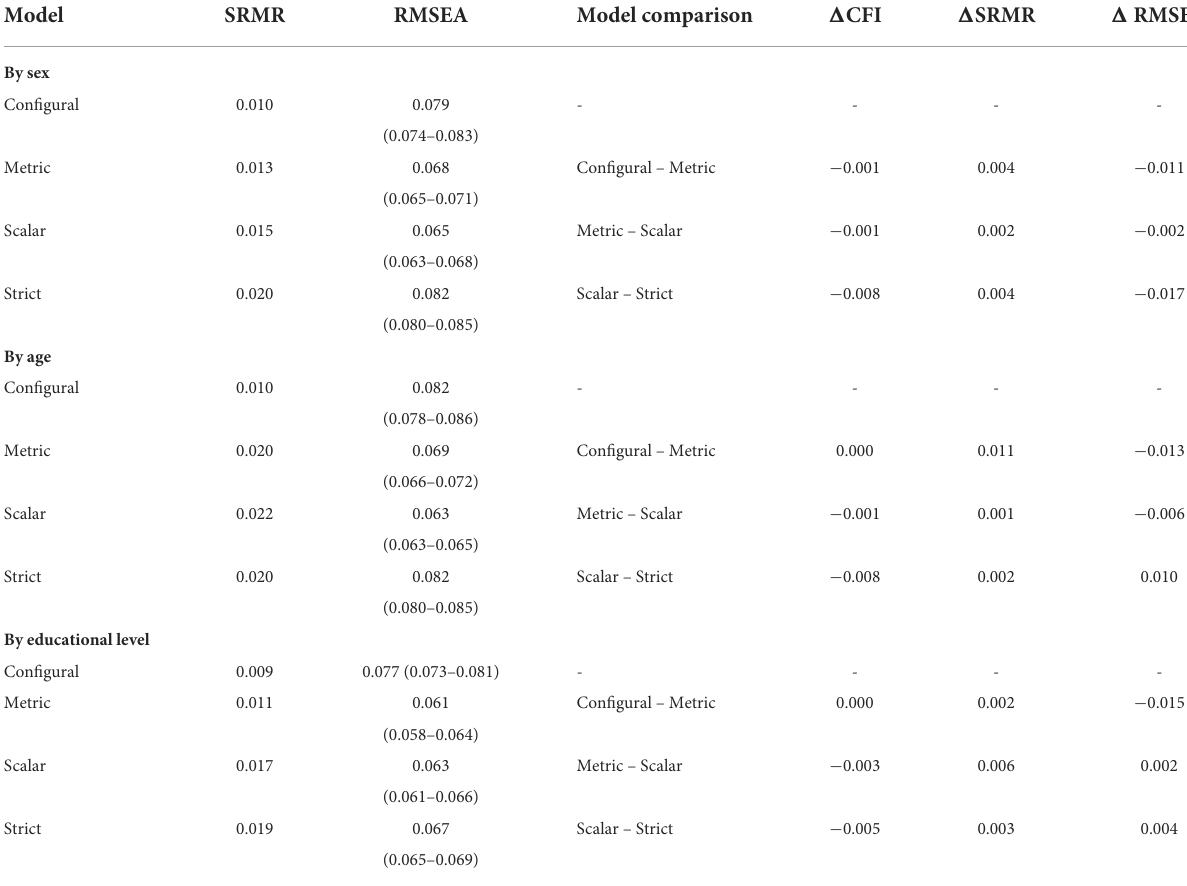
TABLE 4 Alternative fit indices to evaluate measurement invariance by sex, age, and education.